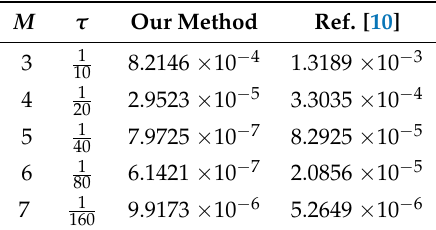
Table 4. Comparison of the maximum absolute errors (MAEs) with [10] of Problem 3 for α = 1.25 and for different values of M